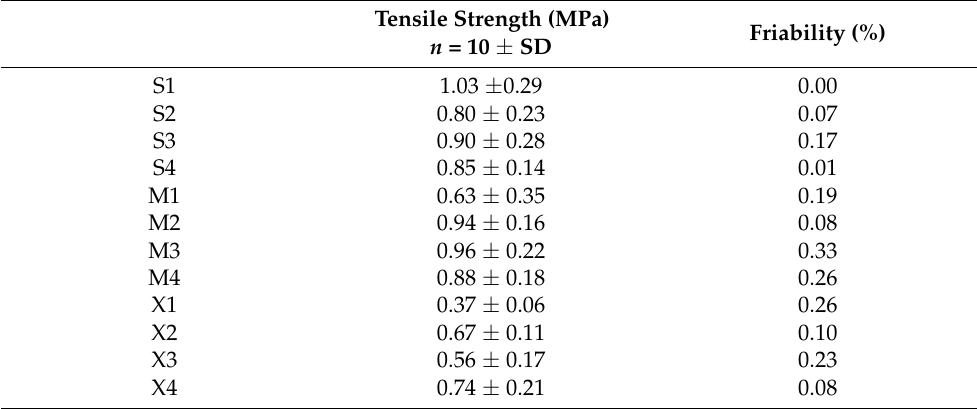
Table 3. Friability and tensile strength of CHD mucoadhesive buccal